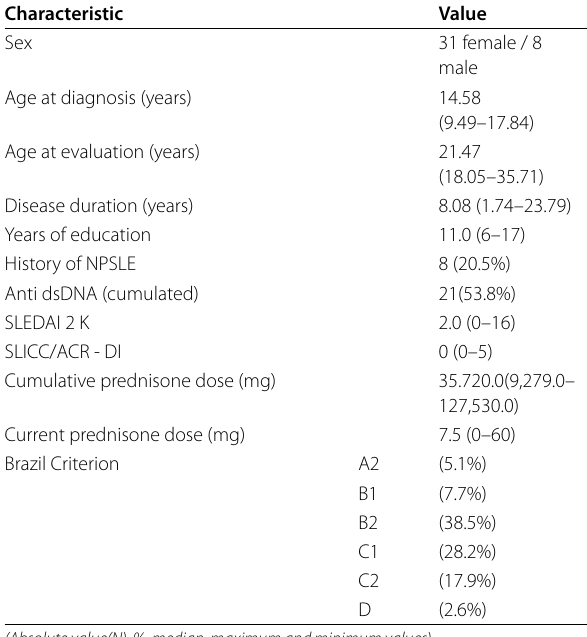
Table 1 Demographic and clinical characteristics for 39 patients with childhood-onset systemic lupus erythematosus